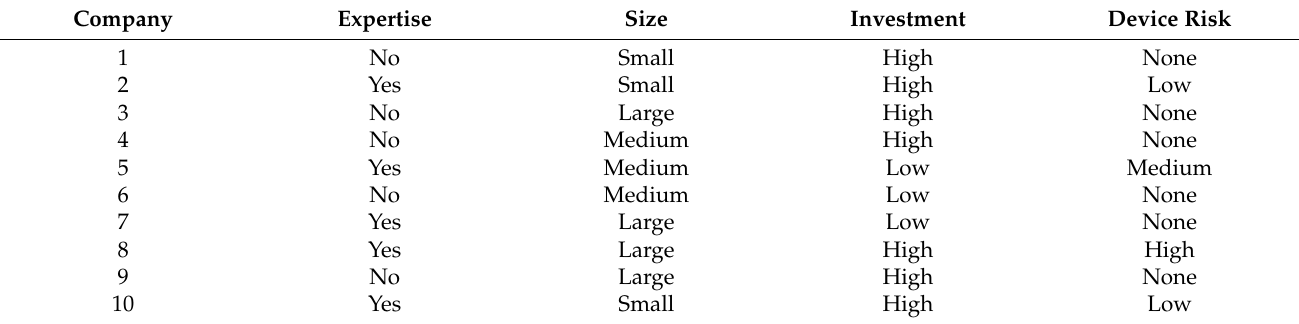
Table 1. Device risk dataset used to compare the different decision tree algorithms. The “Expertise” column captures the human capital within a company with regards to medical devices. The “Size” indicates the number of employees within a company. The “Investment” shows how much invest- ment that company had attracted, whilst the “Device risk” shows the risk of the medical devices they